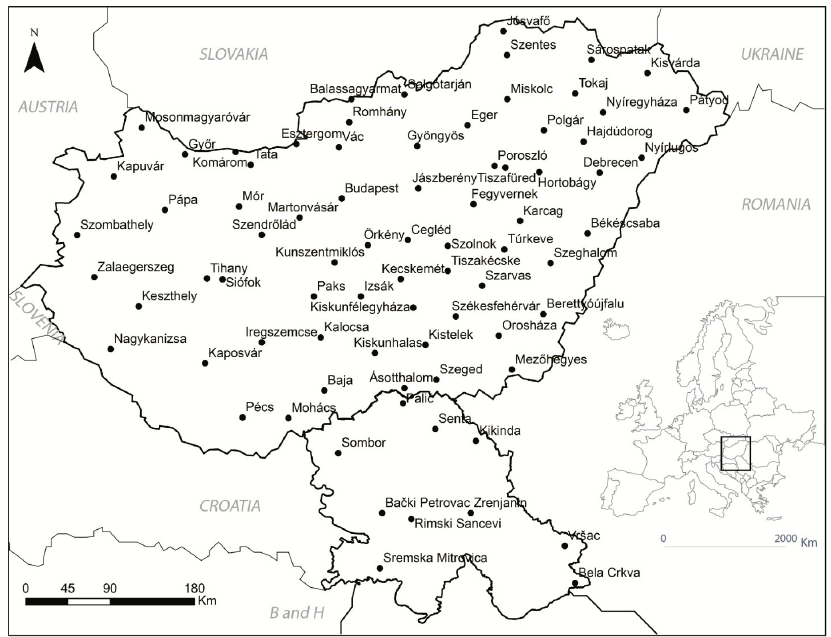
Figure 1. Territories of Hungary and Vojvodina in the Central and Southern Pannonian Basin (CSPB), their locations in Europe, and meteorological stations used in this study.